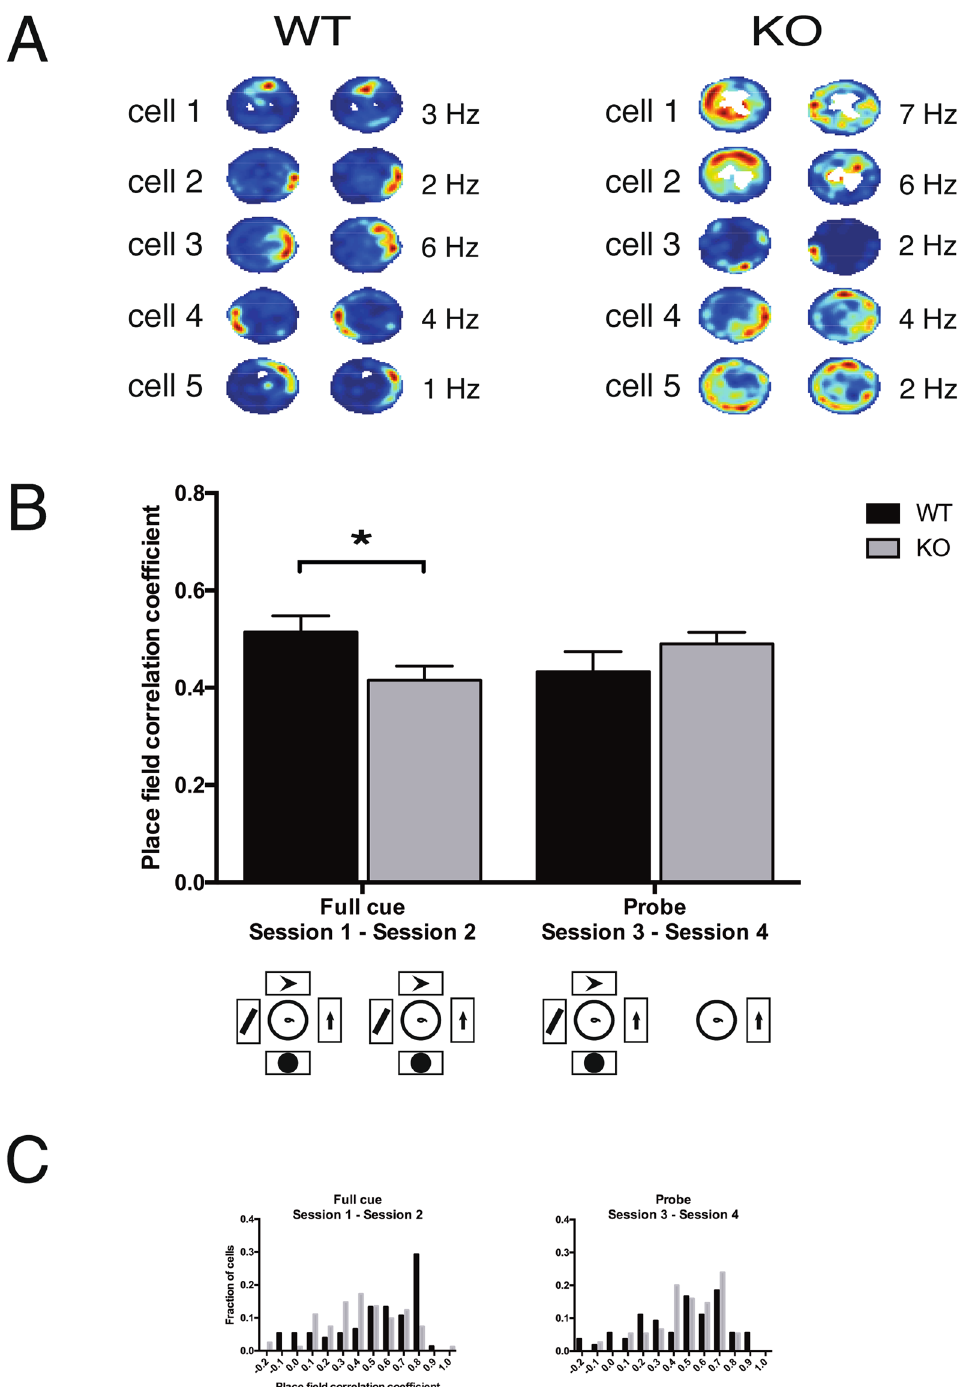
Figure 4. Stability of firing rate maps between sessions. ( A ) Example WT and KO firing rate maps (selected across all mice and sessions), split between the first (left panels) and second (right panels) daily recording sessions, to illustrate the stability of each map. Each heat map is scaled by the maximum firing rate (indicated in Hz) of the cell within that session. Areas of the arena that were not visited during the recording session are marked in white. ( B ) Correlation of WT (black) and Fmr1 -KO (gray) firing rate maps. Data are represented as mean ± SEM. Full cue session: WT 75 fields, mean = 0.51, SEM = 0.03; KO 81 fields, mean = 0.42, SEM = 0.03. Probe session: WT 54 fields, mean = 0.43, SEM = 0.04; KO 75 fields, mean = 0.49, SEM = 0.02. ( C ) Distributions of the stability of WT (black) and Fmr1 -KO (gray) pyramidal cells. * P < 0.05 (Bonferroni’s multiple comparisons